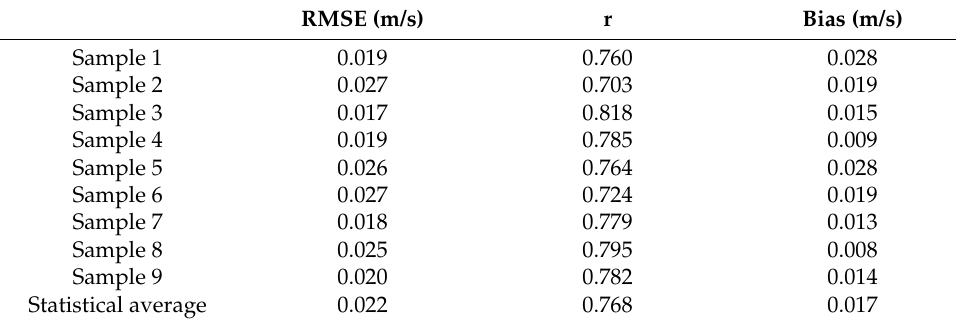
Table 3. Statistics of the estimation results.